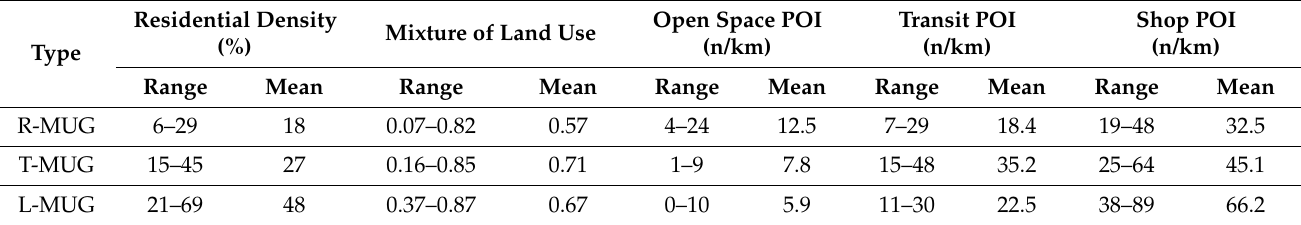
Table 5. Environmental features of surroundings.